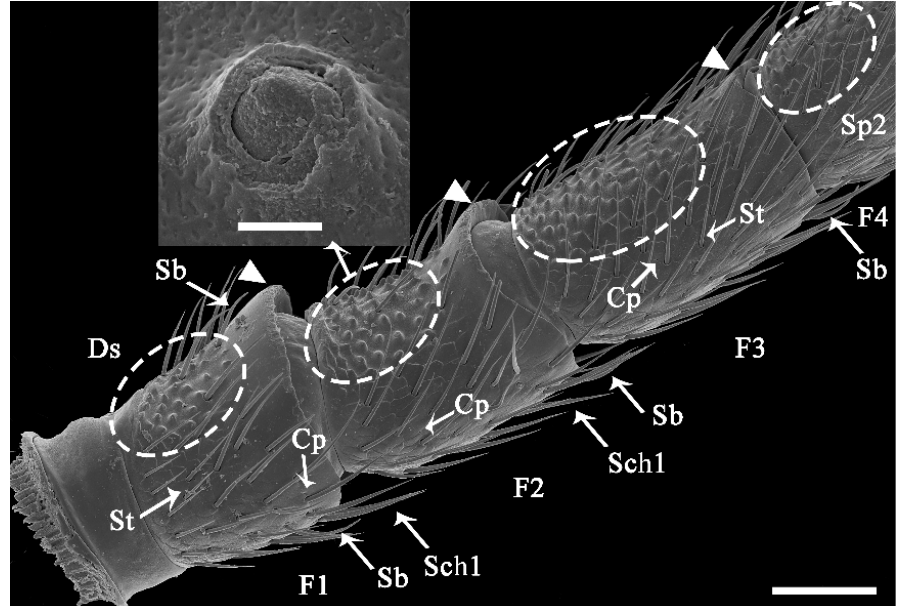
( A ) = 10 µ m; ( B ) = 500 nm. = 10 μ m; ( B ) = 500 nm.